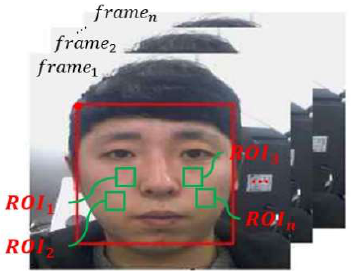
Figure 16. Selection of multiple ROIs.